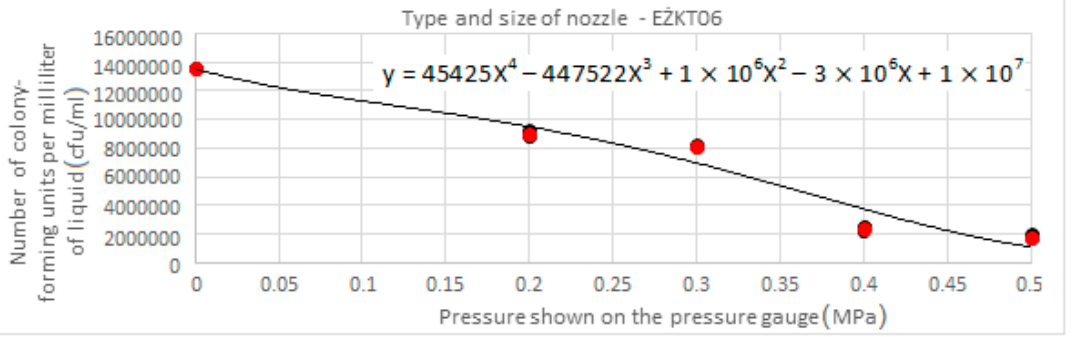
Figure 13. The influence of pressure on survival of cfu/mL of liquid for E Ż KT06.